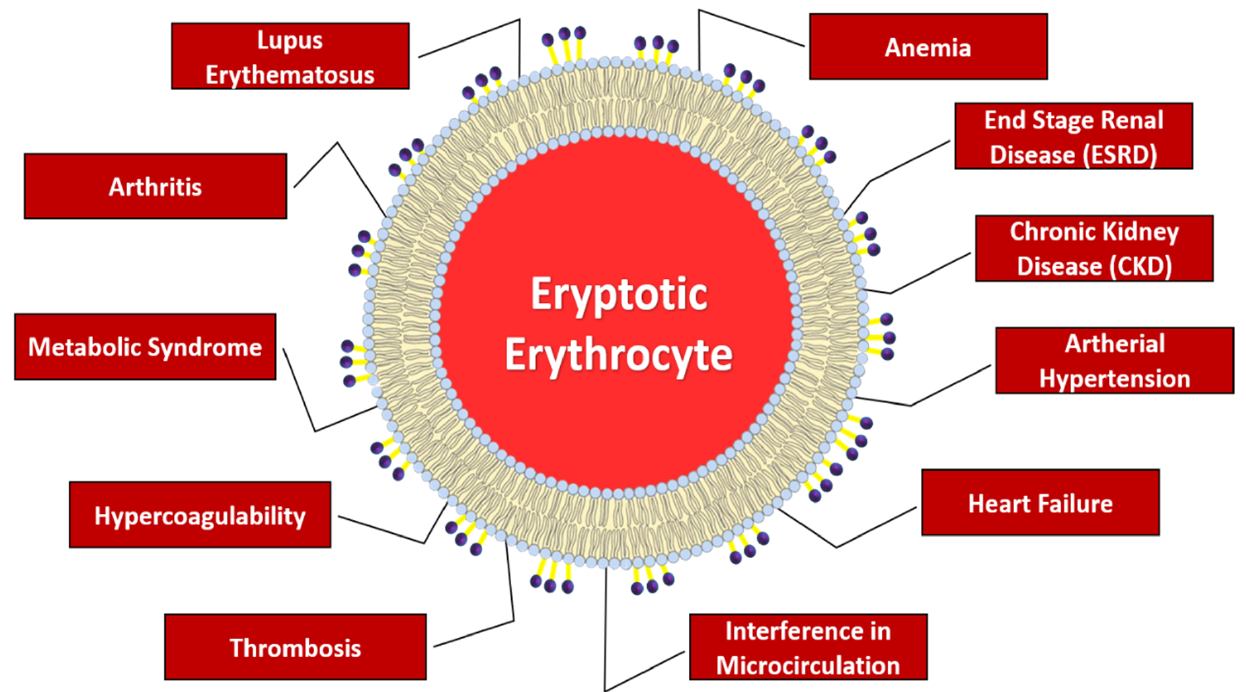
Figure 2. Main diseases related to an excess of eryptosis.